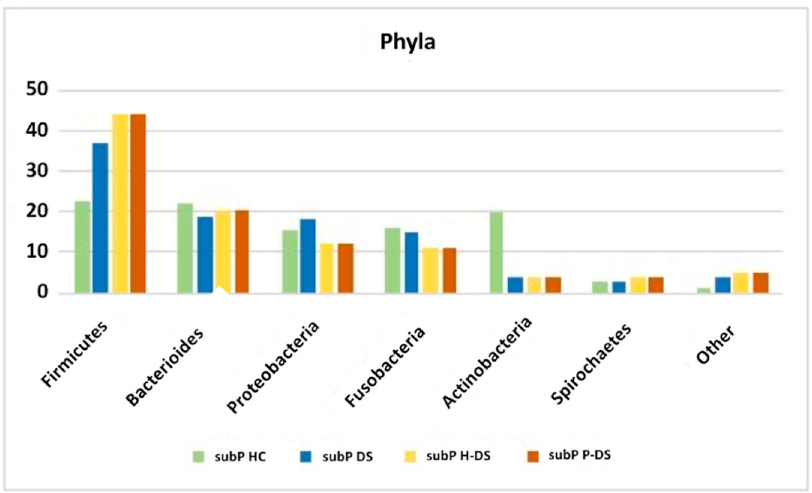
Figure 3. The most represented phyla, as reported form Segata et al. [48] for subgingival plaque of HC (subP HC), and from Novoa et al. [52], for subgingival plaque of DS, irrespective of periodontal status (subP DS), and in those with (subP P-DS) and without periodontitis (subP H-DS).